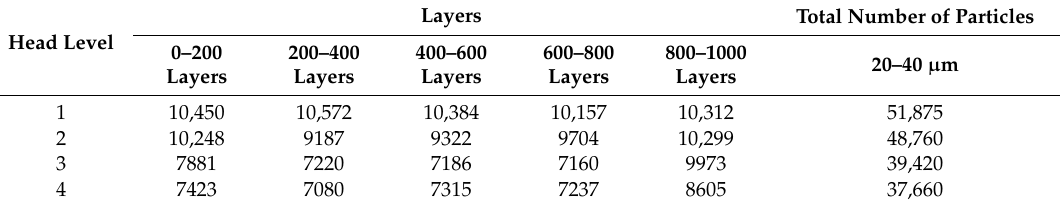
Table 9. Variation in the number of fine particles percolated with the 30% fine content (20–40 µ m).